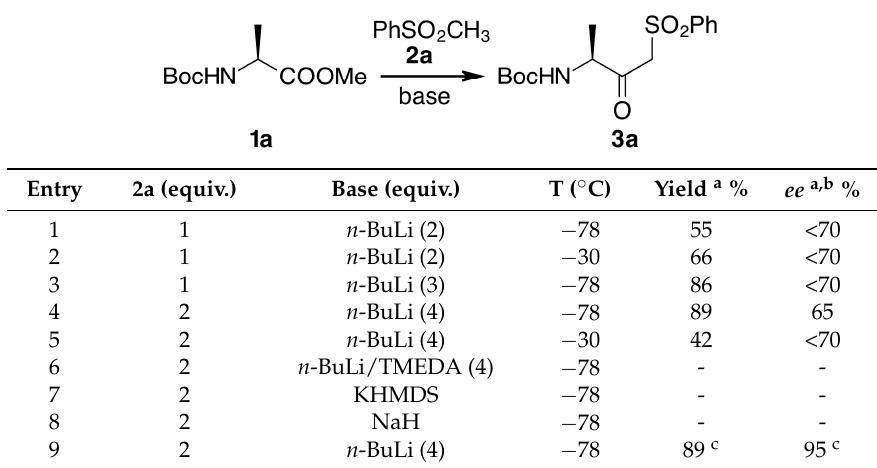
Table 1. Optimized synthesis of ketosulfone 3a .